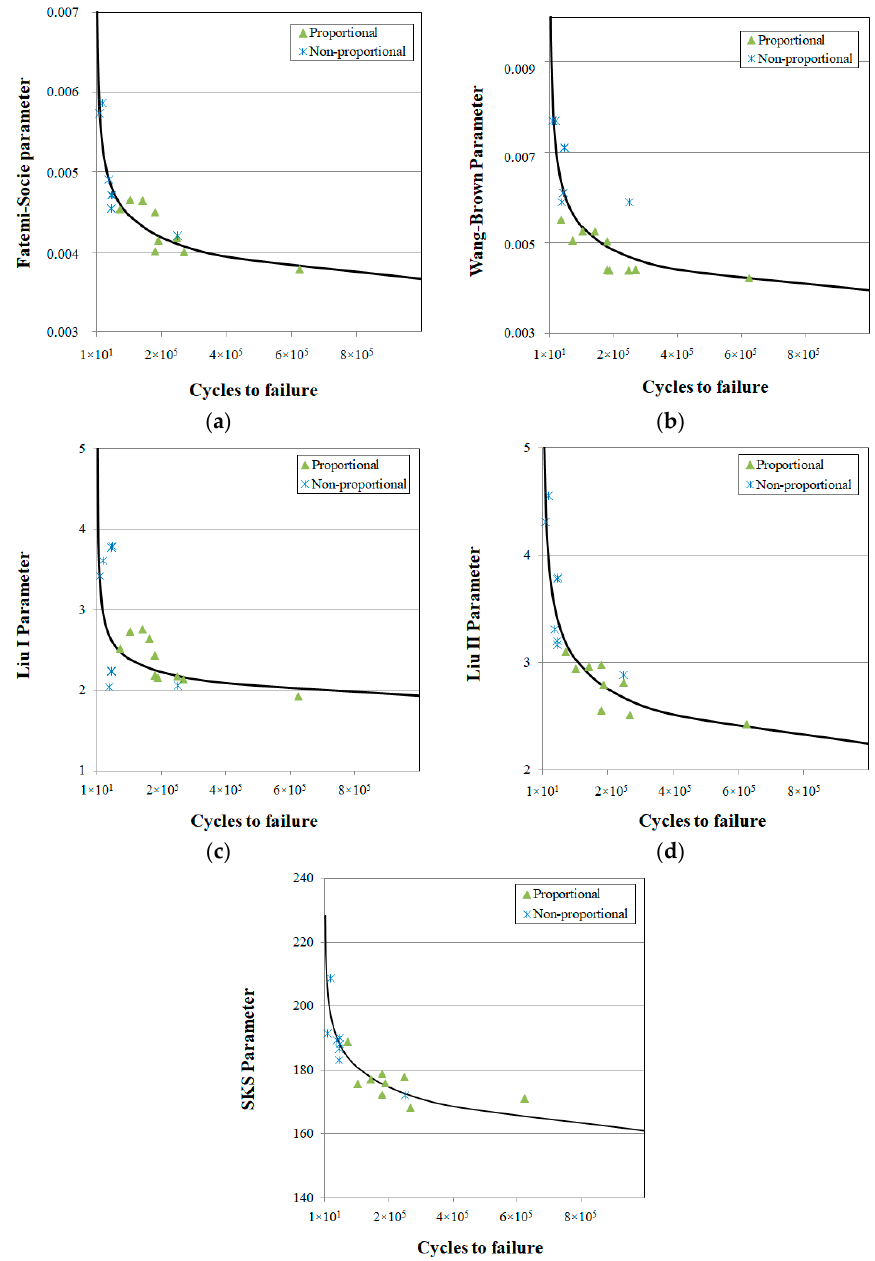
Figure 3. Correlation of S355-J2G3 fatigue data with ( a ) FS, ( b ) WB, ( c ) Liu I, ( d ) Liu II and ( e ) SKS damage parameters.